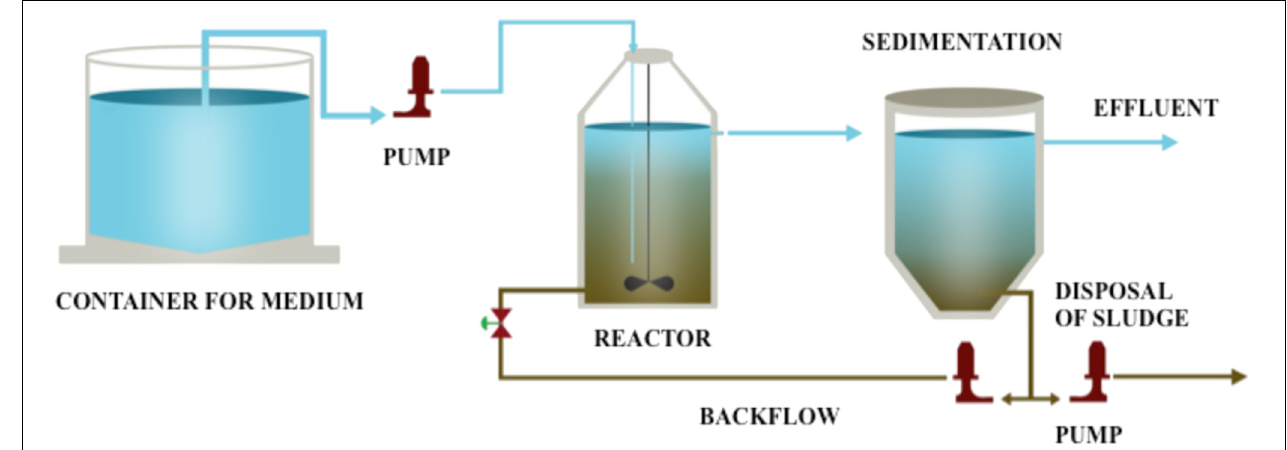
FIGURE 1 | Schematic diagram of the